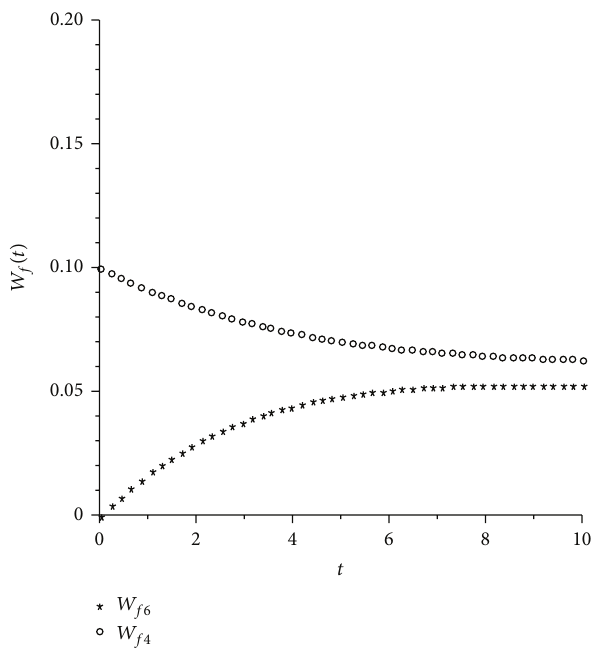
Figure 7: Instantaneous failure frequencies of the systems with and without warning device with 𝛼 = 0.2 .